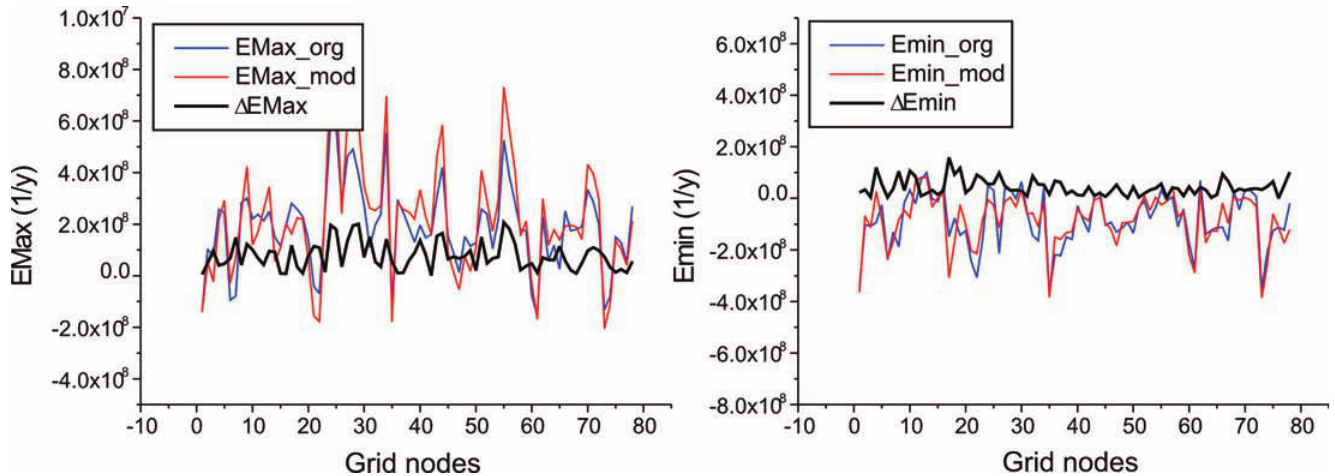
Figure 7. Principal strain rates computed using the standard velocity patterns and the threshold-modified patterns. The differences between the modified and original eigenvalues (thick black lines) have means of 0.8 × 10 −8 y −1 (standard deviation 0.5 × 10 −8 y −1 ) for the maximum eigenvalues (left panel),